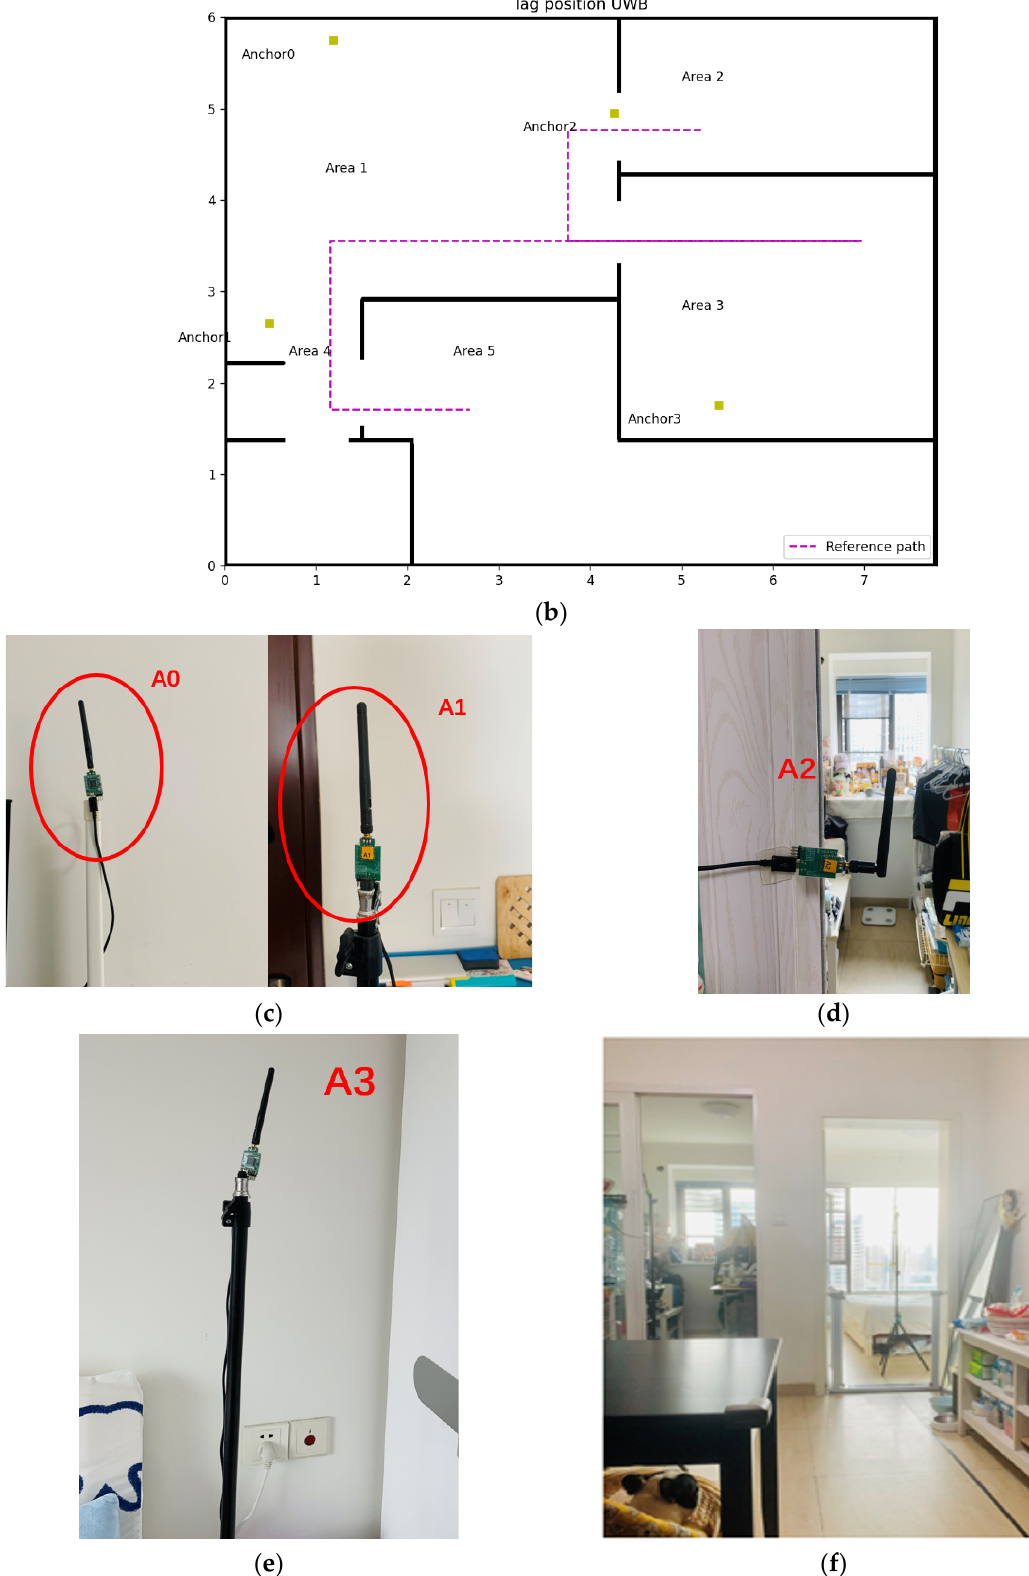
Figure 6. Experiment design: ( a ) Map of experiment 1, ( b ) Map of experiment 2, ( c ) Anchor 0 & 1, ( d ) Anchor 2, ( e ) Anchor 3, ( f ) Overall experiment environment.